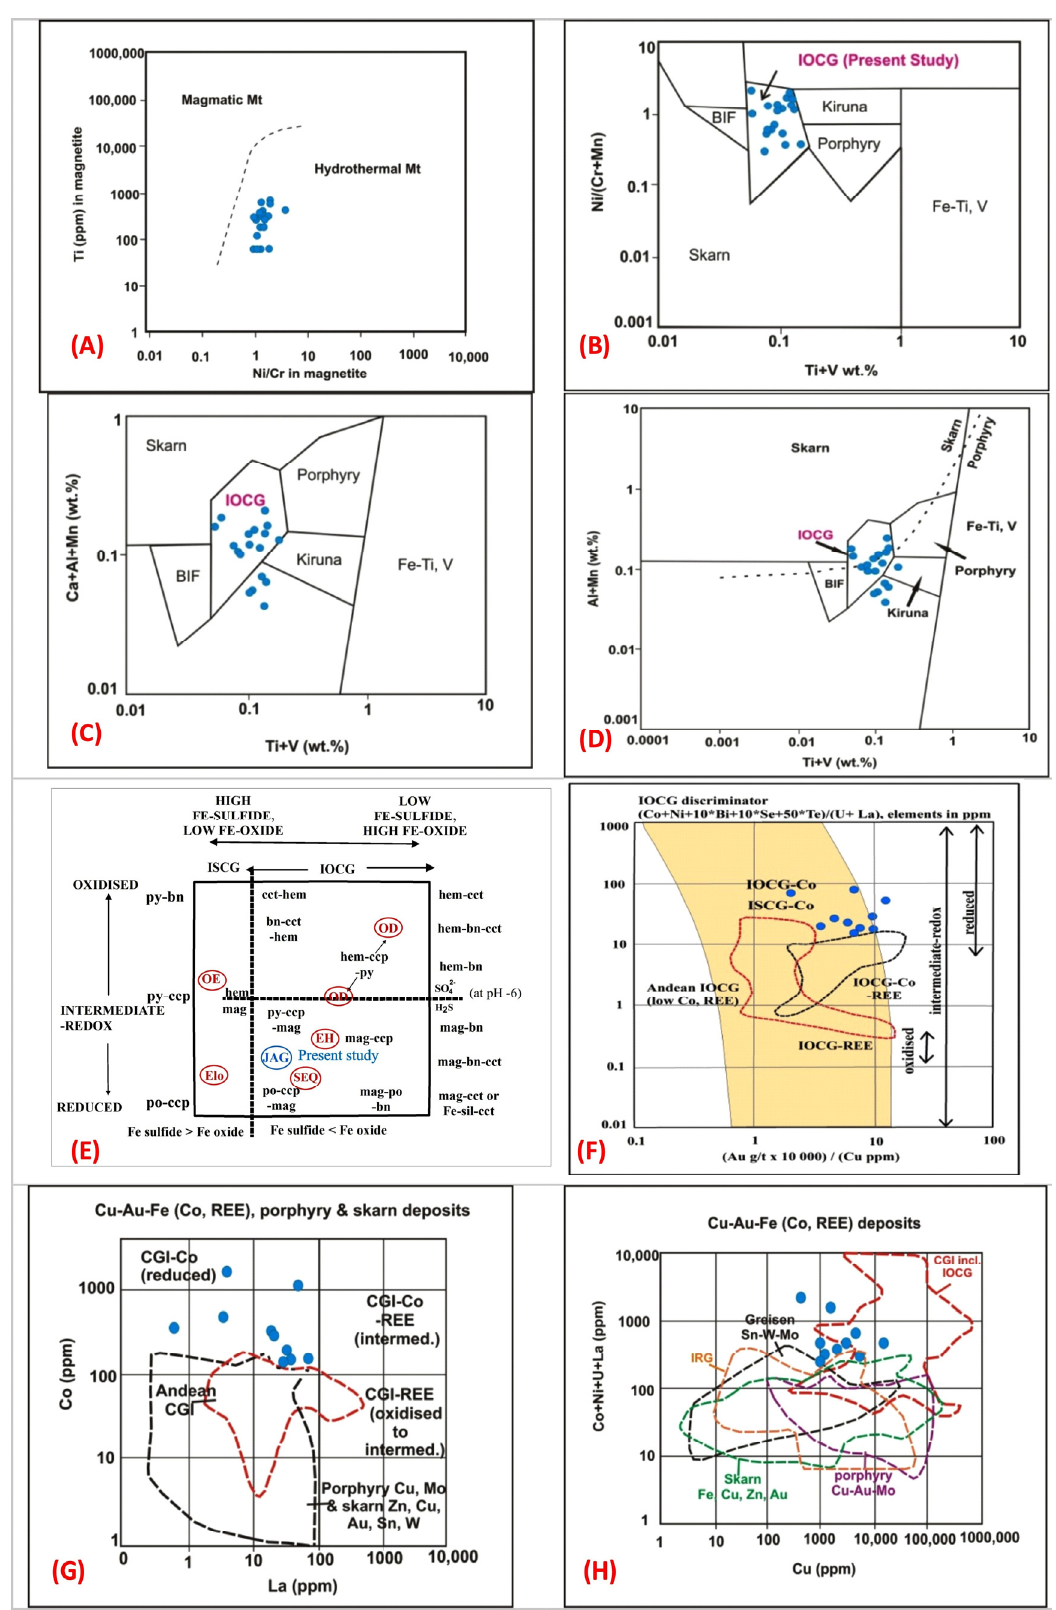
Figure 9. Trace elements plots of magnetite and geochemical discrimination diagrams suggesting IOCG type mineralization style in the study area. ( A ) Ti vs. Ni/Cr ratio of magnetite from reference [14] suggest hydrothermal nature of magnetite; ( B ) Ni/(Cr+Mn) vs. Ti+V plot from reference [18] suggesting IOCG type deposit; ( C ) Ca+Al+Mn vs. Ti+V plot from reference [18] indicates IOCG type